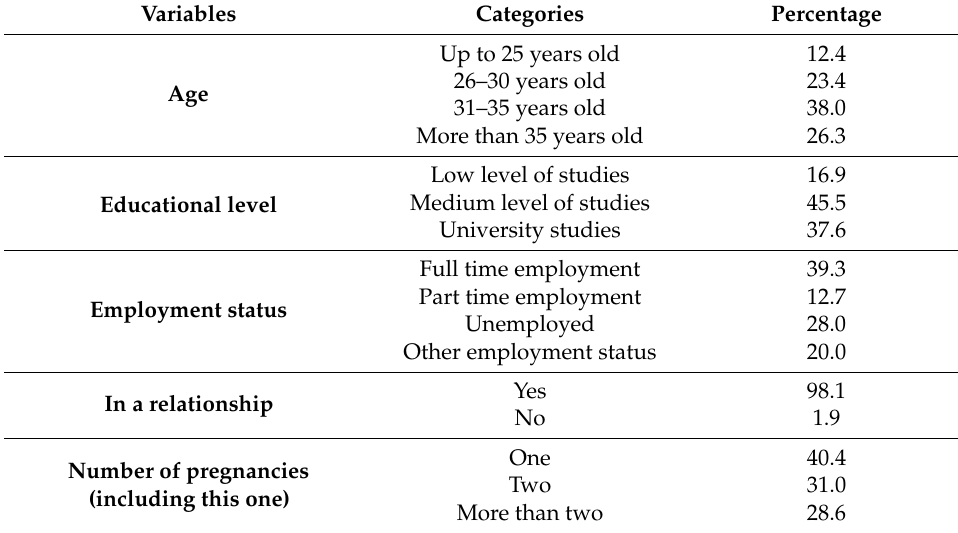
Table 1. Descriptive characteristics of the sample and frequency of alcohol